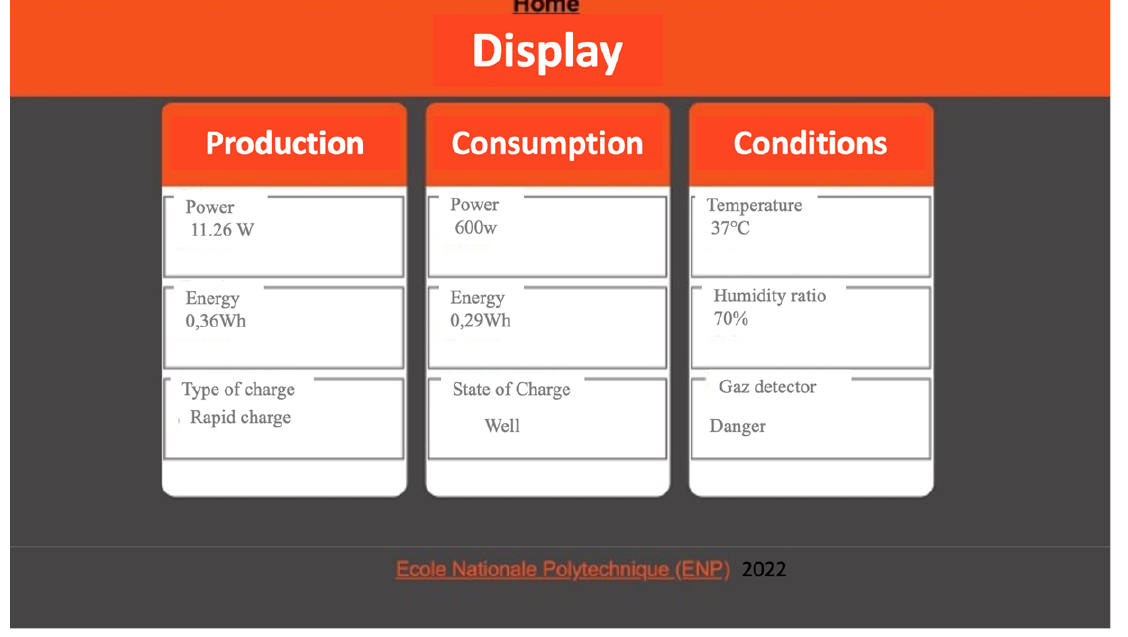
Figure 9. Realization of the model of the solar house.